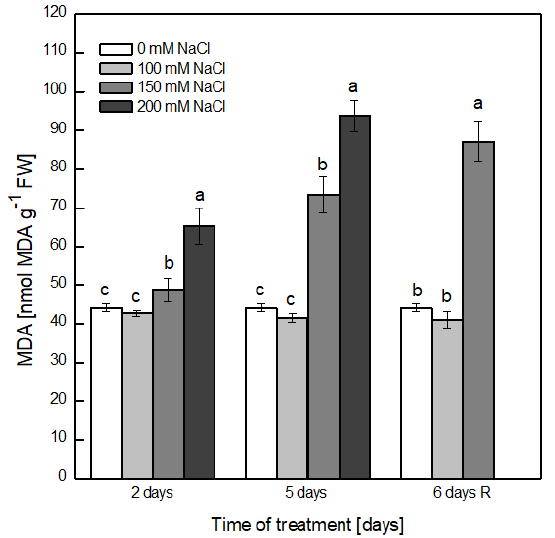
Figure 2. Extent of lipid peroxidation determined by the level of malondialdehyde (MDA) formation in the leaves of pea plants treated with 0, 100, 150 and 200 mM NaCl for 2 and 5 days and after recovery (6 days R). Results are presented as means ± SE. In three independent experiments, four parallel samples were evaluated at each time point ( n = 12). Different letters indicate significant differences between values for the control plants (0 mM NaCl) and plants treated with increased concentrations of NaCl at p < 0.05 for the respective period of the experimental setup (2 and 5 days of treatment and the recovery period).